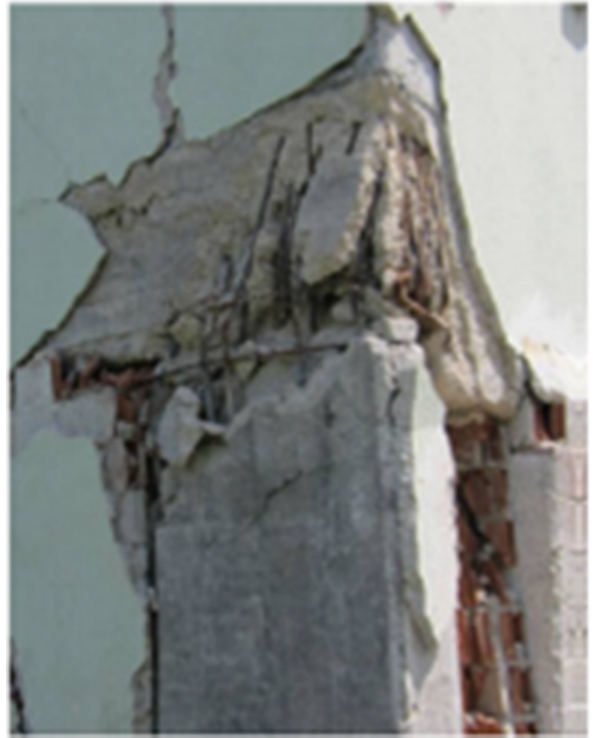
Figure 10. A reinforced concrete structure that was heavily dam- aged at the joint region during the 19 May 2011 Simav earthquake (Caycı, 2012).